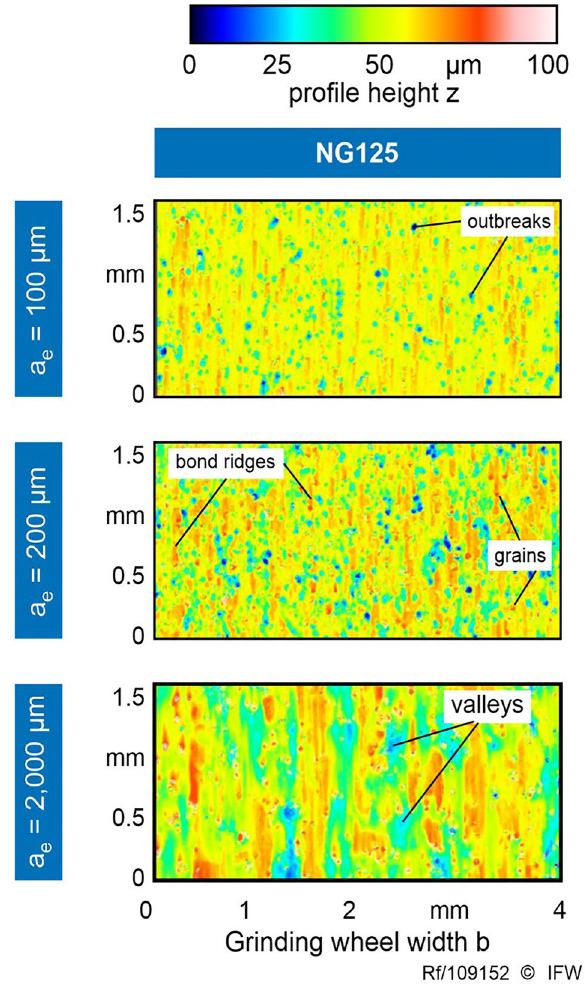
Fig. 7 Topography image sections of grinding wheel